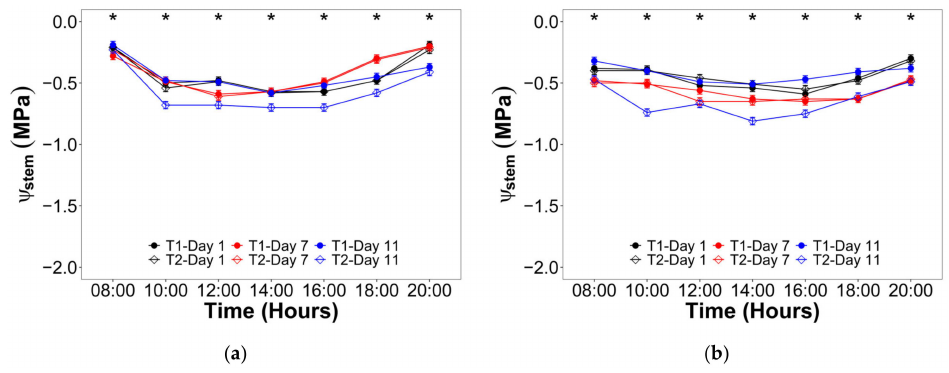
Figure 3. Hourly evolution of stem water potential ( ψ stem ) for the irrigation treatments (T1 = Control; T2 = Drought) during the three evaluated days in: ( a ) Vegetative stage; ( b ) Flowering stage. Significant differences between irrigation treatments in the three evaluated days for every hour are indicated by an asterisk.